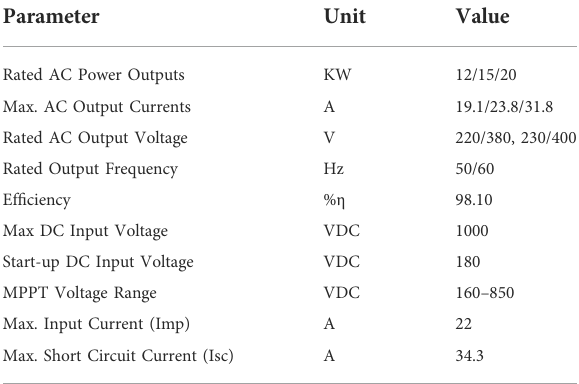
TABLE 5 Technical speci fi cation of CSI-T400GL01-E inverter series. Parameter